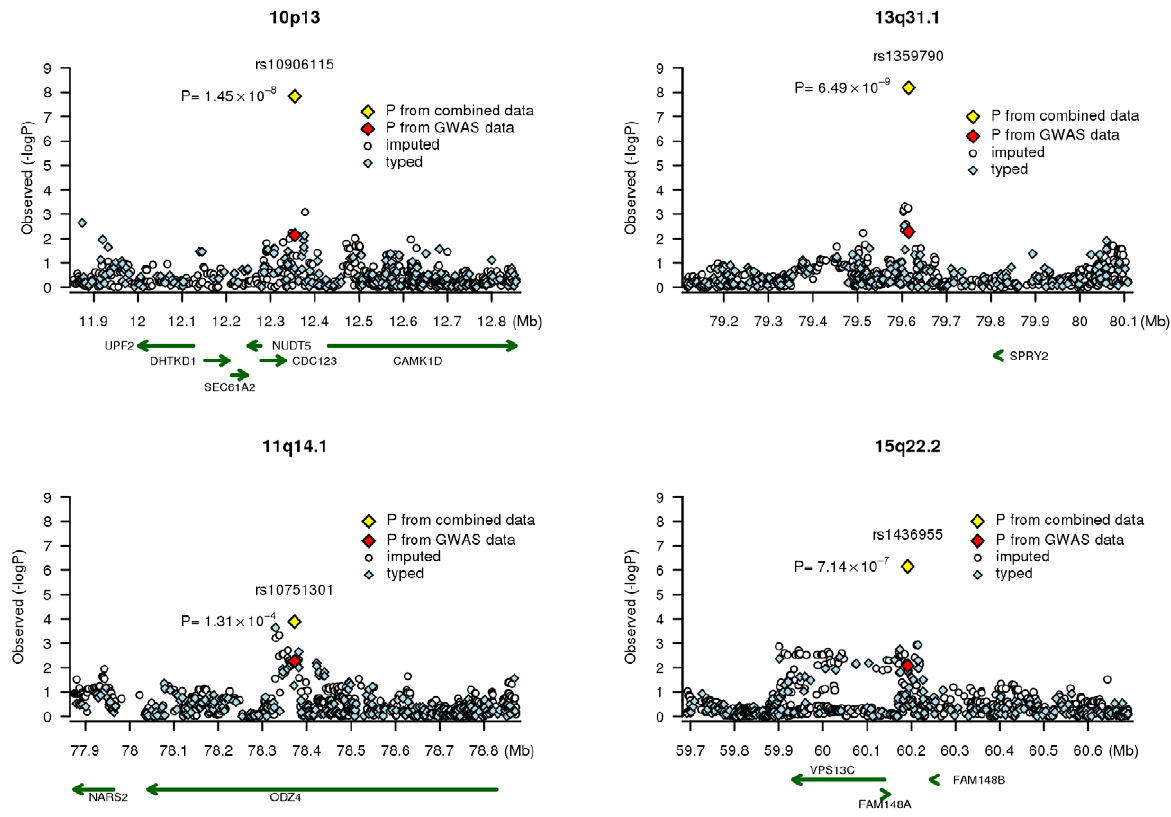
Figure 2. Association signals at four chromosome regions. Results (-logP) are shown for directly genotyped (blue diamonds) and imputed (white circles) SNPs for a 1Mb region centered on the SNP of interest. Gene locations are from the March 2006 UCSC genome browser assembly.